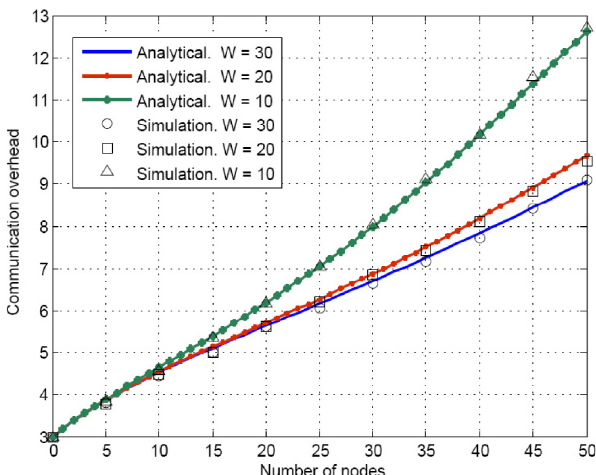
Figure 11. Communication overhead of the IPAA protocol as a function of network size with contention window size as a